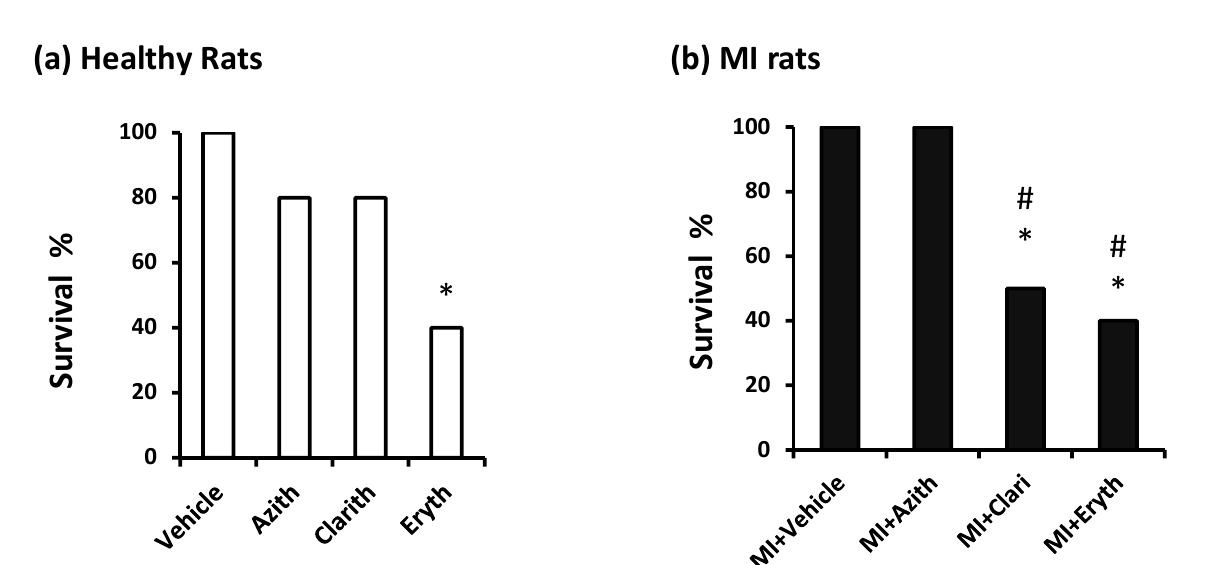
Figure 6. Survival percent in the two rat experiments. ( a ) healthy rats, and ( b ) acute MI rats. Survival % was calculated in normal or MI rats treated with azithromycin (Azith), clarithromycin (Clarith), or erythromycin (Eryth). MI: myocardial infarction. Data in each set were analyzed separately by Chi-square Test. Data are % out of 10 rats. * Different from the vehicle group at p less than 0.05. # Different from the azithromycin (Azith) group of the same experiment at p -value less than 0.05.